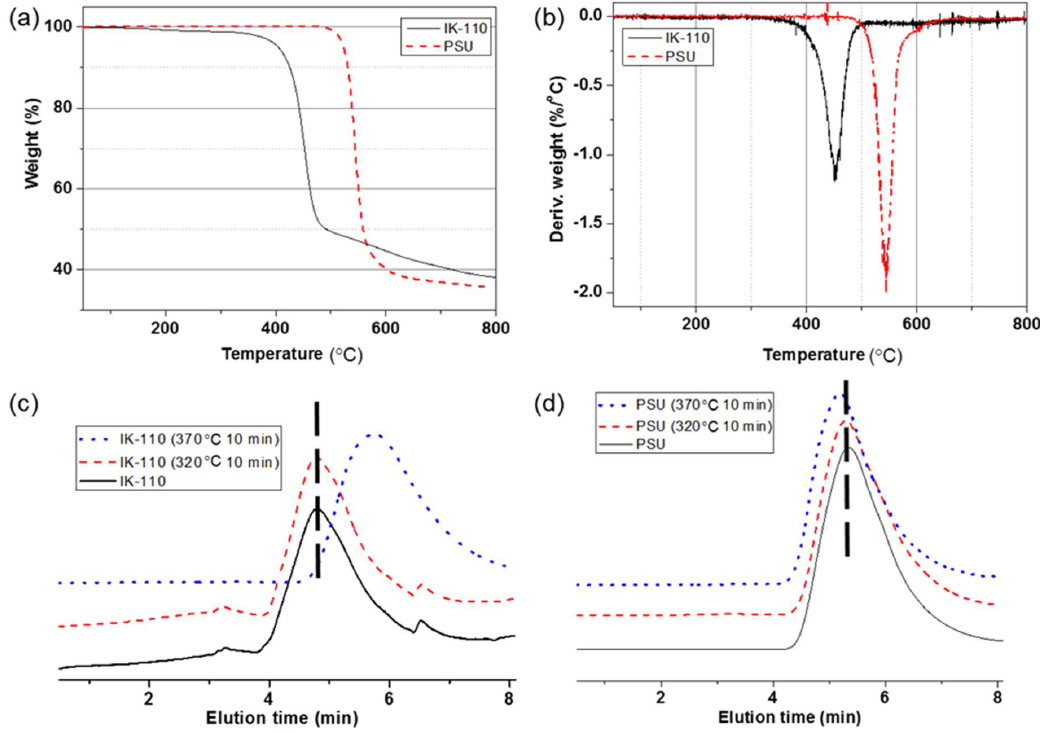
Figure 4. ( a ) Thermogravimetric analyzer (TGA) and ( b ) DTG curves of IK-110 and PSU. Chloroform-GPC profiles of ( c ) IK-110 and ( d ) PSU after thermal stress. Table 3. Thermal stability, transparency, hardness, and thermal expansion of polymers. IK-110 PSU